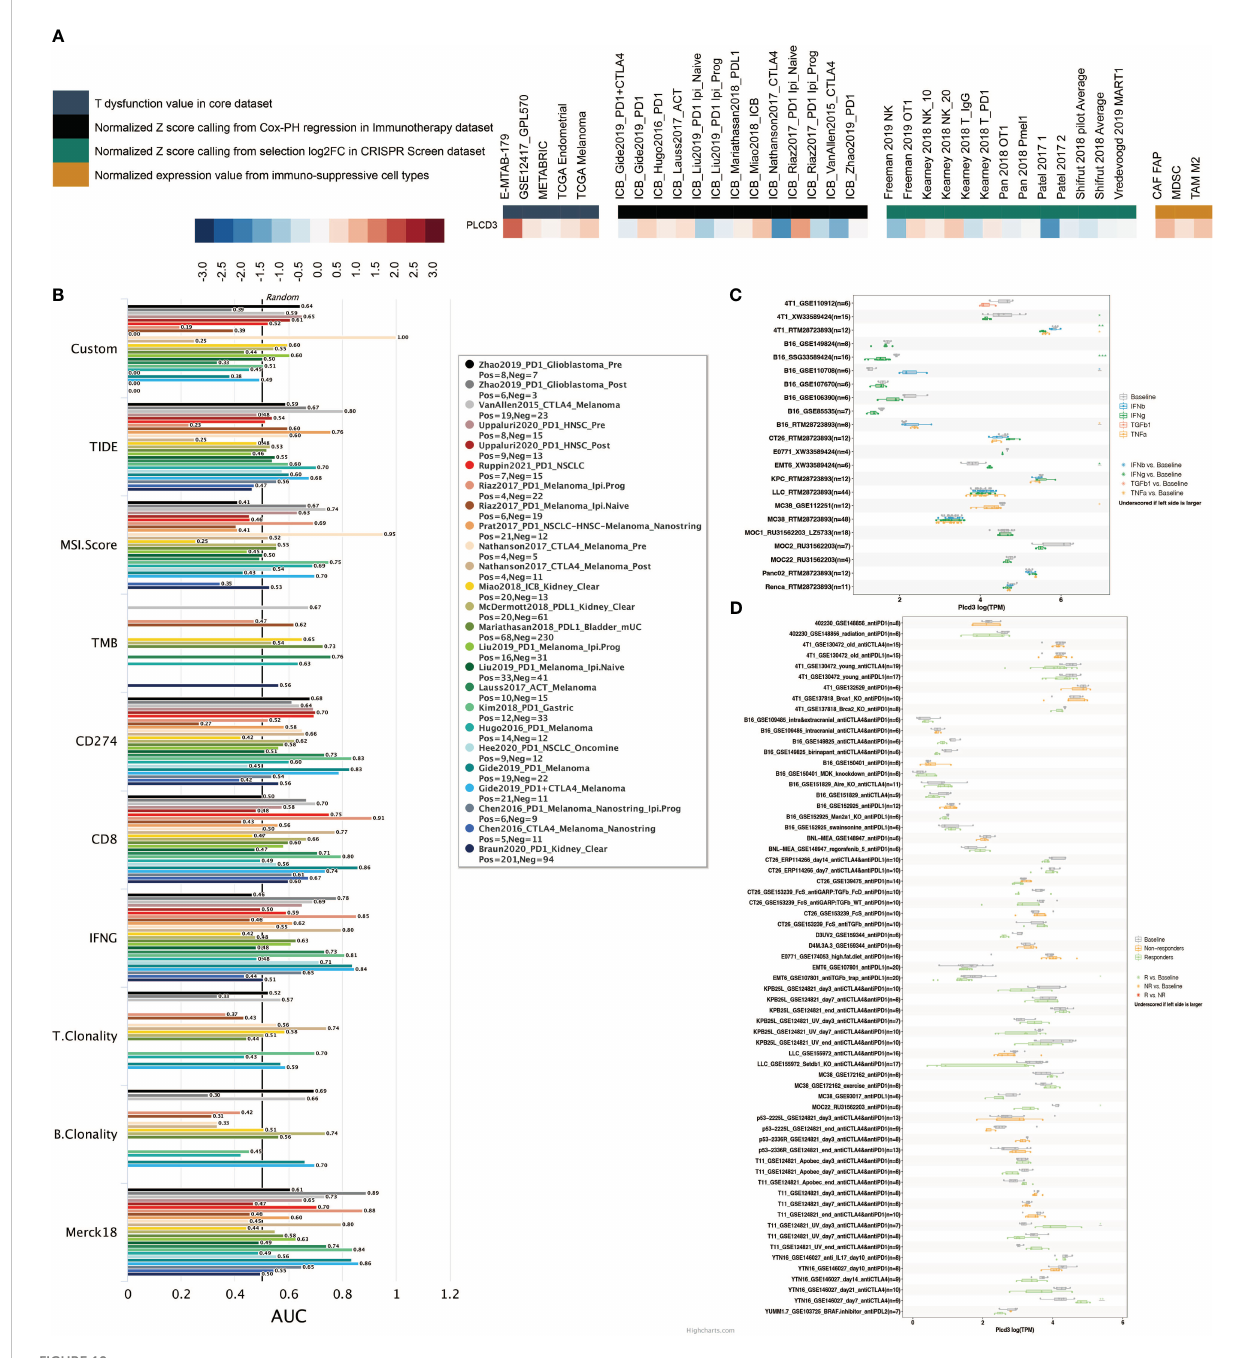
FIGURE 10 Immunotherapy prediction of PLCD3. (A) Regulator prioritization performed by TIDE. (B) Biomarker evaluation by TIDE. (C) Cytokine treatment prediction by TISMO. (D) Immunotherapy prediction by